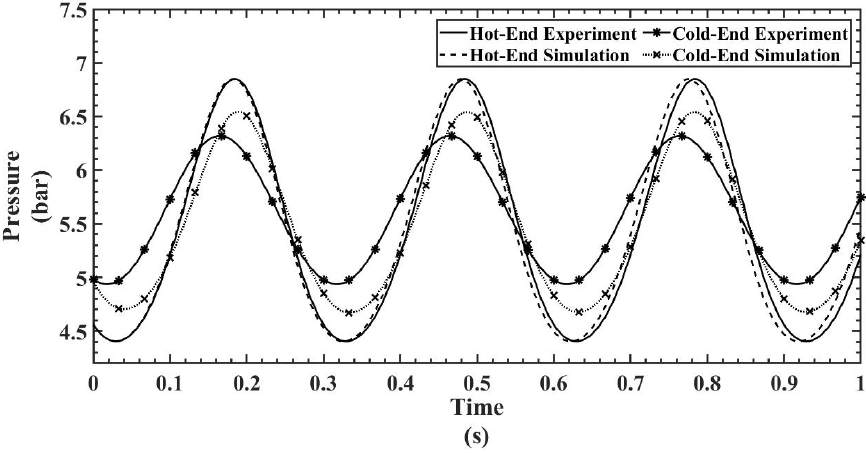
Figure 14. Hot- and cold-section pressure characteristics of a 200 mesh regenerator at 200 RPM.